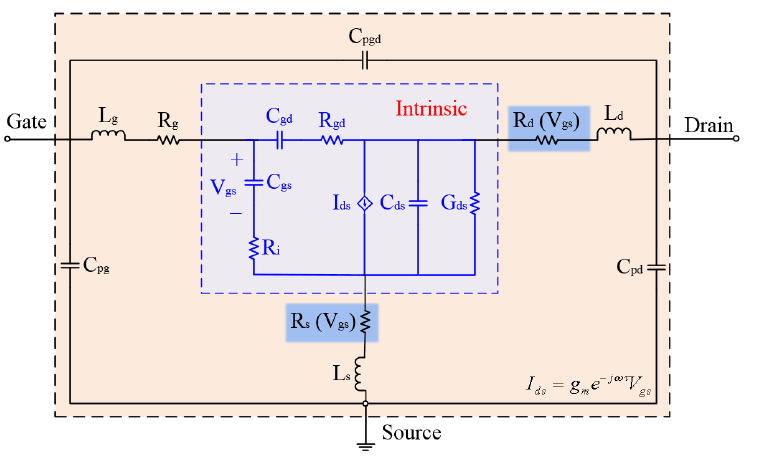
Figure 4. The pHEMT’s small-signal equivalent circuit model shows the extrinsic and intrinsic